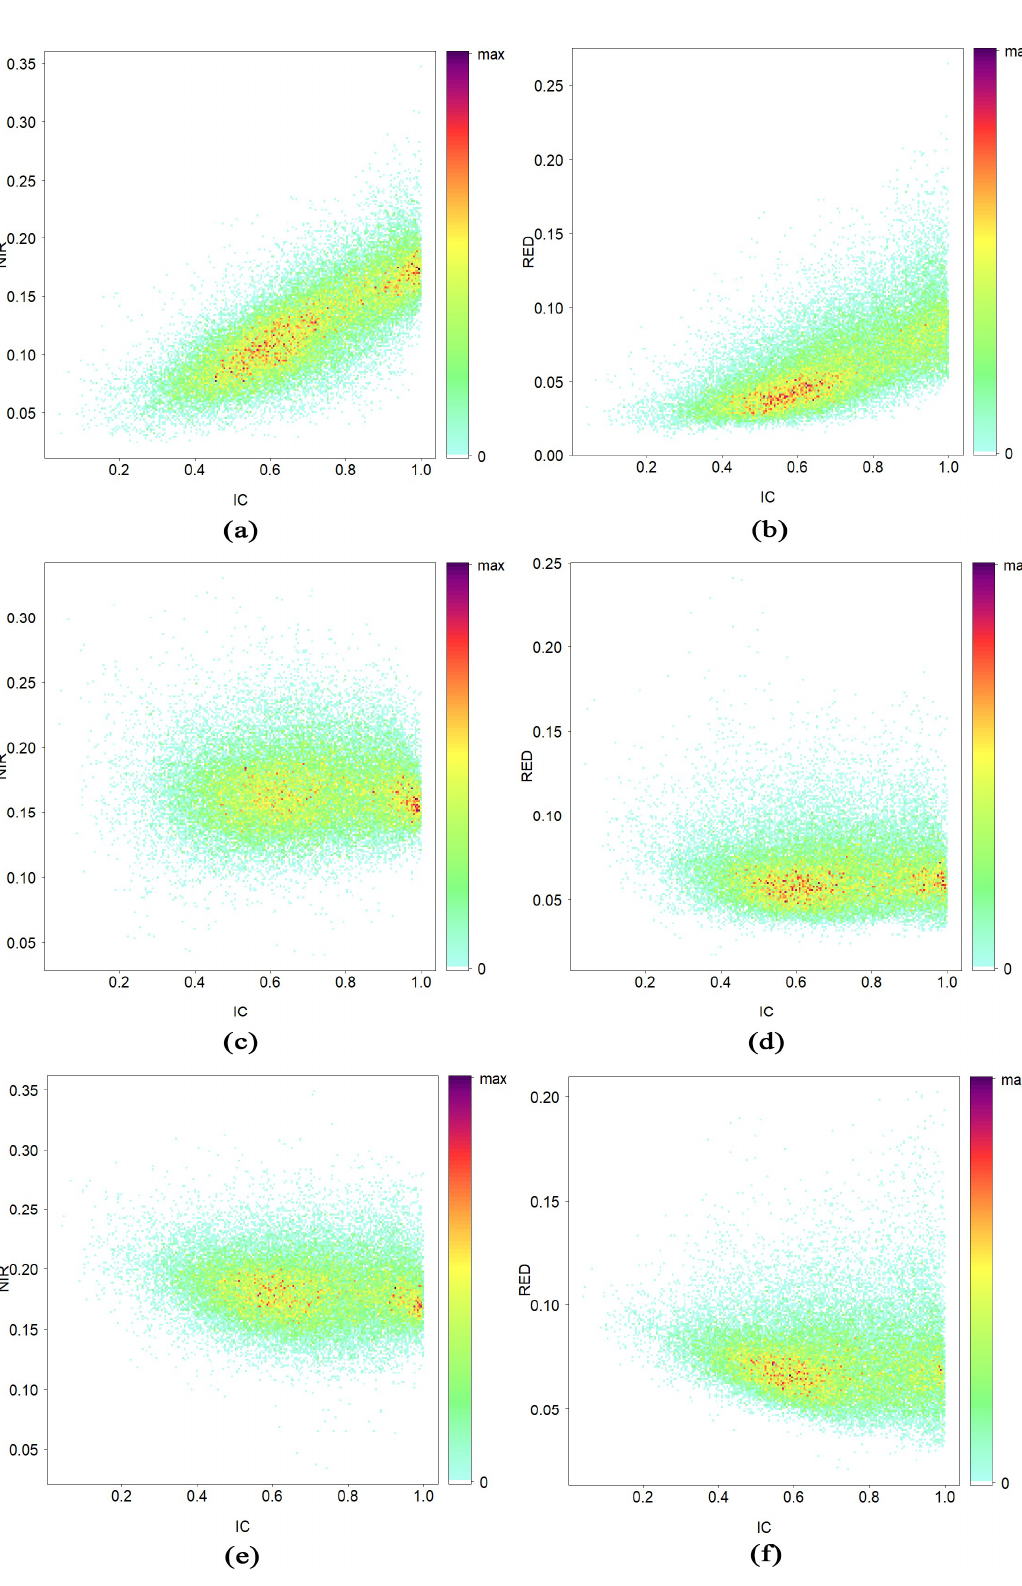
Figure 7. Scatter density map of the spectral band and IC of pine. ( a ) NIR band before correction ( b ) red band before correction, ( c ) NIR band corrected by SCS + C model, ( d ) red band corrected by SCS + C model, ( e ) NIR band corrected by empirical rotation model and ( f ) red band corrected by empirical rotation model.